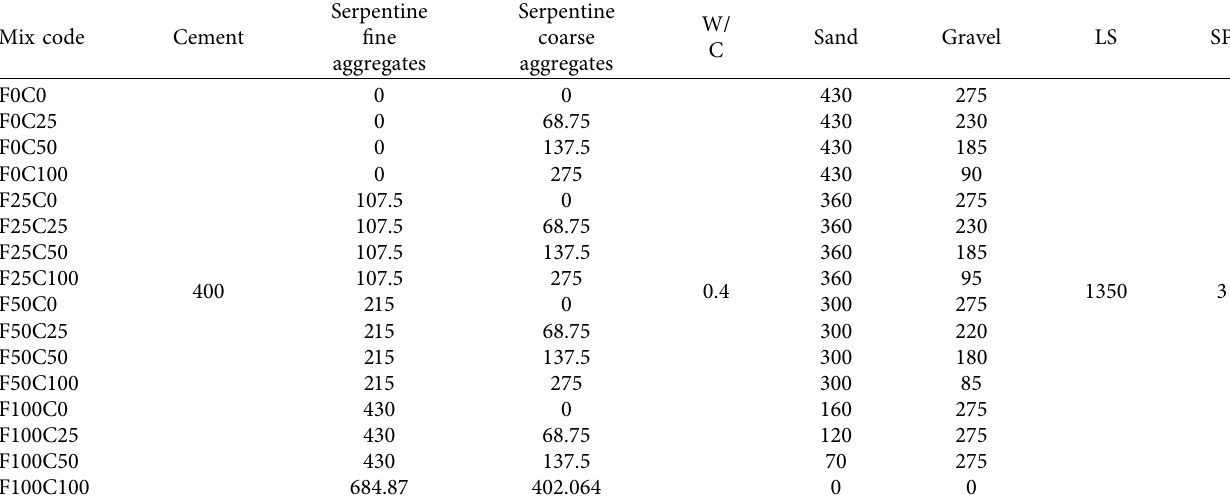
Table 2: Mixture design (kg/m 3 ).